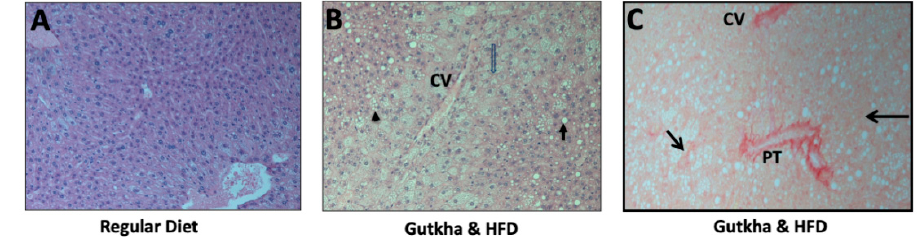
Figure 3. Stained Liver Sections . ( A ) H&E staining of mice fed normal diet showed little or no steatosis or fibrosis. ( B ) H&E staining of some mice, particularly males exposed to gutkha in utero and then fed a HFD, showed evidence of microsteatosis (arrowhead), macrosteatosis (black arrow) and fibrosis (open arrow). ( C ) Sirius red staining of collagen helps to highlight areas with a “chicken wire” pattern of fibrosis (black arrows) typical of non-alcoholic steatohepatitis. Representative images (100 × ) from male o ff spring are shown. CV-central vein. PT-portal tract.